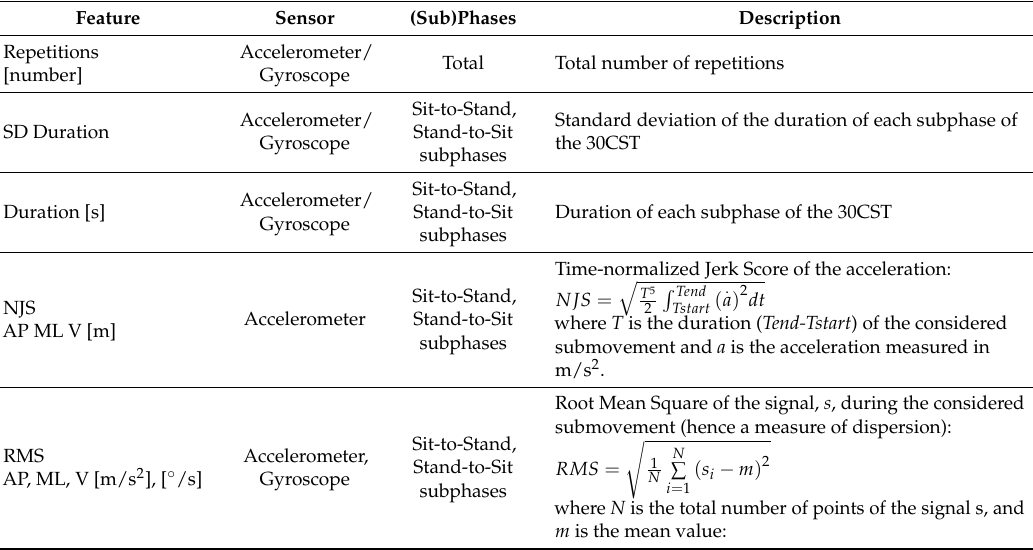
Table 1. Instrumented features extracted from the 30-s Chair Stand (30CST) test.